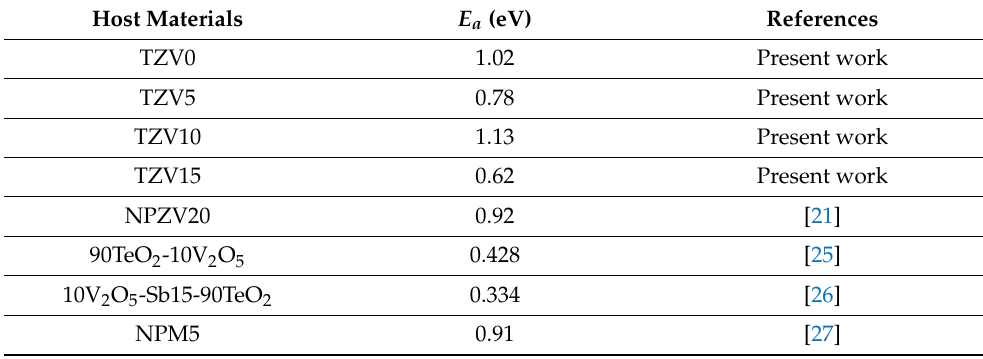
Table 2. Activation energies of the prepared samples and comparison with bibliography.